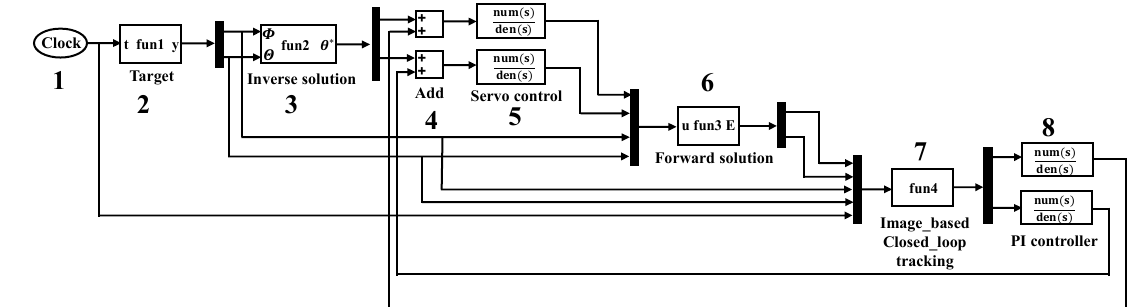
Figure 6. IBCLT control model diagram of the Risley prism system.